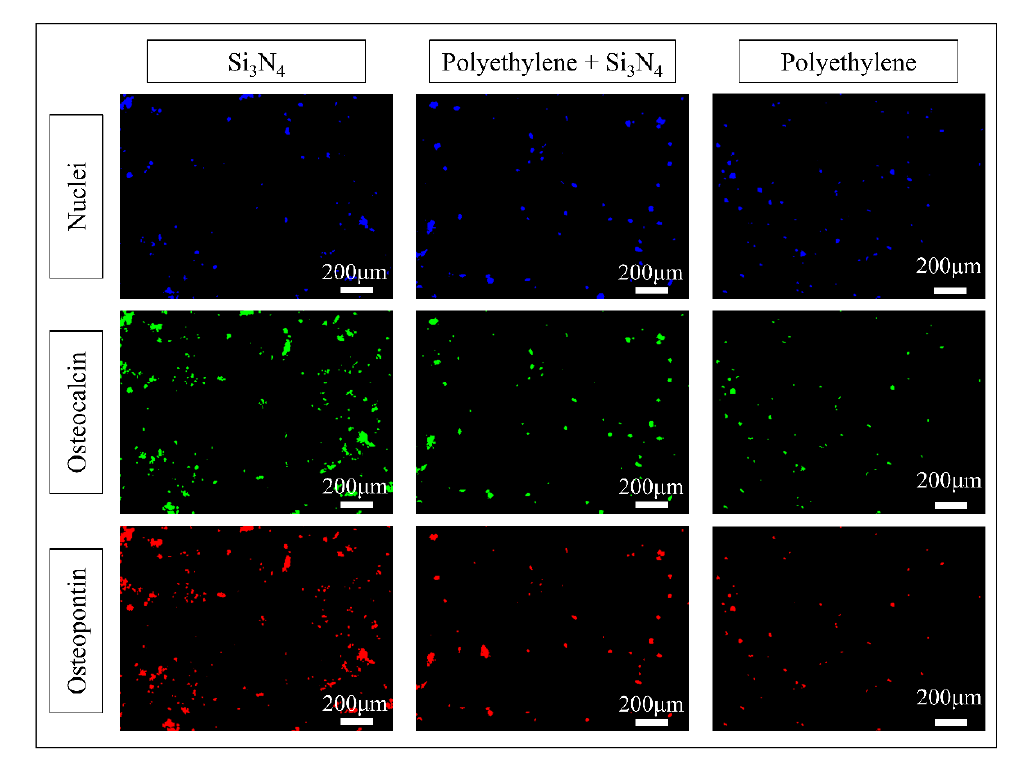
Figure 10. Fluorescence micrographs of the investigated samples after exposure to SaOS-2 cells. Green and red stain marked osteocalcin and osteopontin, respectively, while the blue stain located the cells’ nuclei.